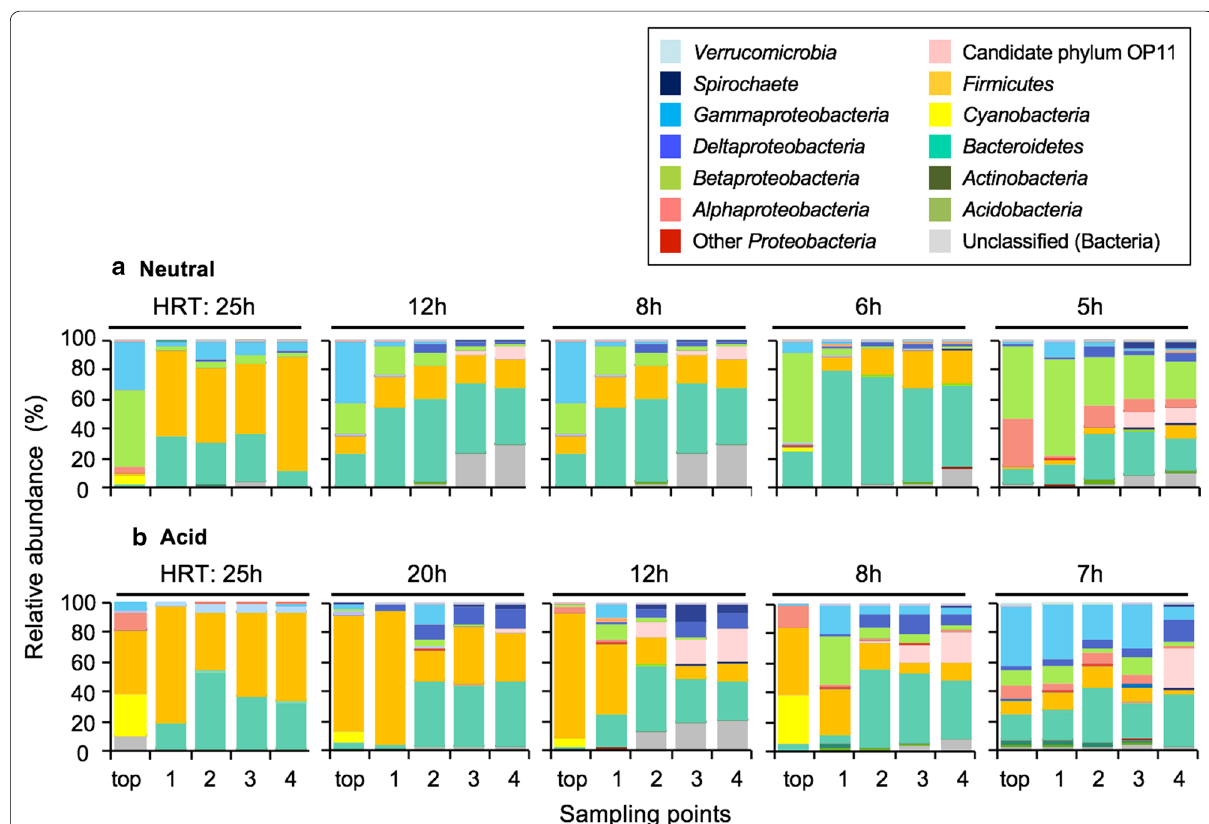
Fig. 4 Phylum- and class-level structural changes of the microbial community during HRT operations under the neutral ( a ) and acid ( b ) conditions. Samples obtained at each depth of the reactor (top and ports 1–4) were analyzed by high-throughput sequencing of 16S rRNA genes. The phylo- genetic groups are indicated by colors and their taxonomies are shown in the upper section of the graph . The color version of this figure is